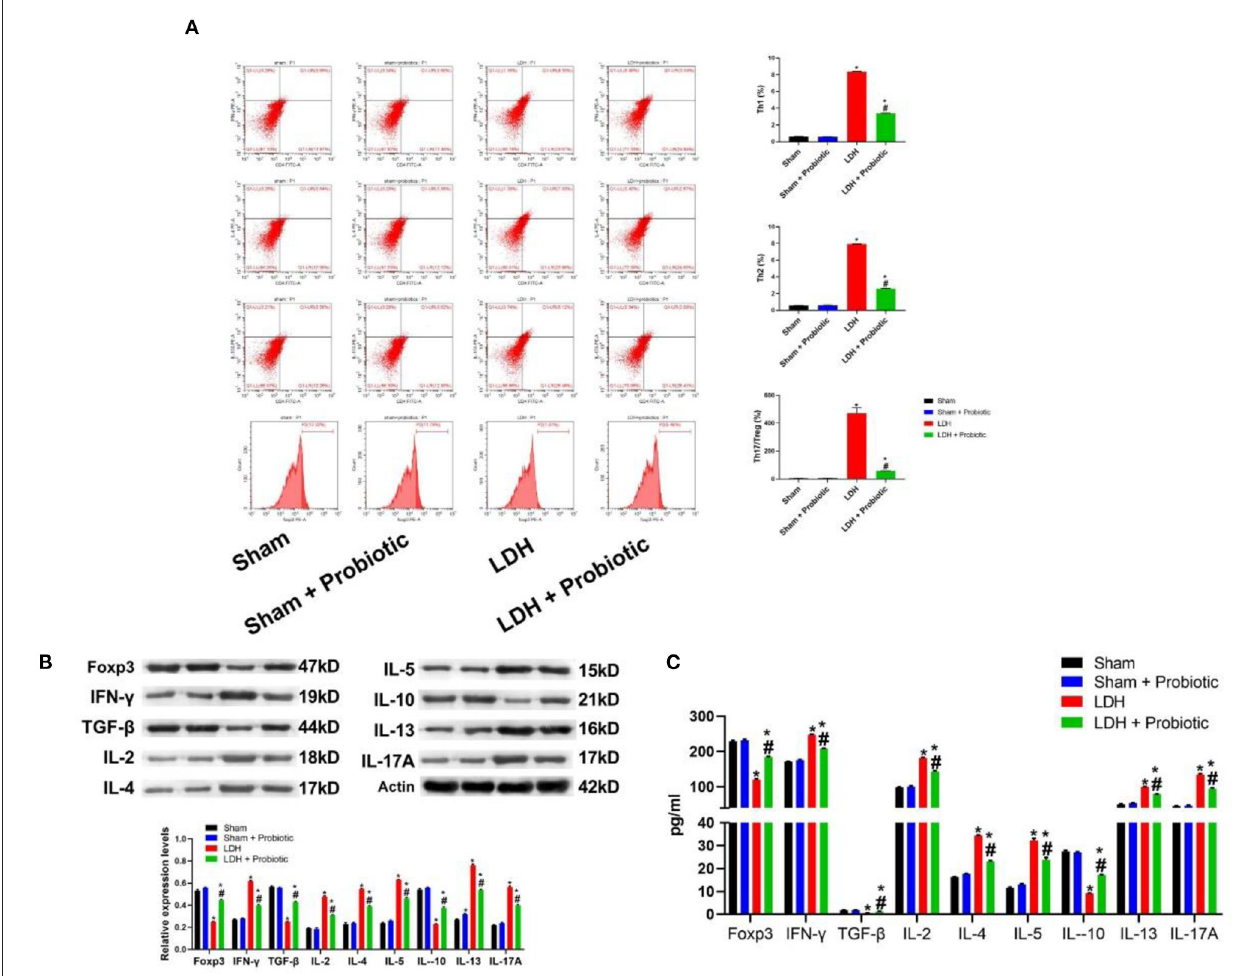
FIGURE 3 | L. paracasei S16 alleviated the aberrant inflammation in LDH mice. (A) Flow cytometric analysis of DRG; (B) Western blot analysis of inflammatory cytokines levels in the DRG; (C) ELISA of inflammatory cytokines in the serum. Data were expressed as the mean ± SEM. * P < 0.05 vs. Sham; # P < 0.05 vs.